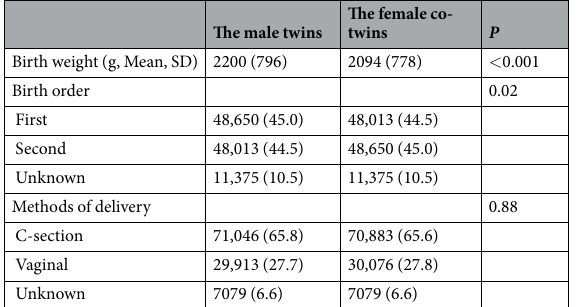
Table 2. The Unmatched Factors between the Male and the Female Co-twins in Mixed Gender Twins.